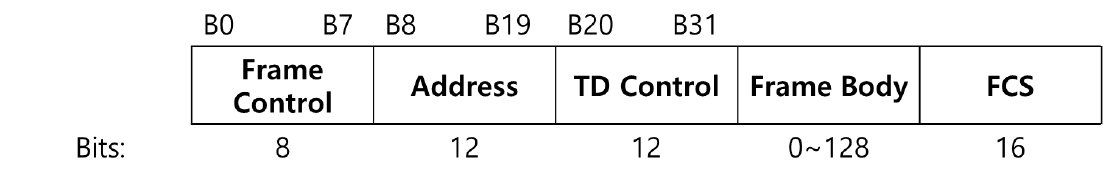
Figure 4. IEEE 802.11ba wake-up frame